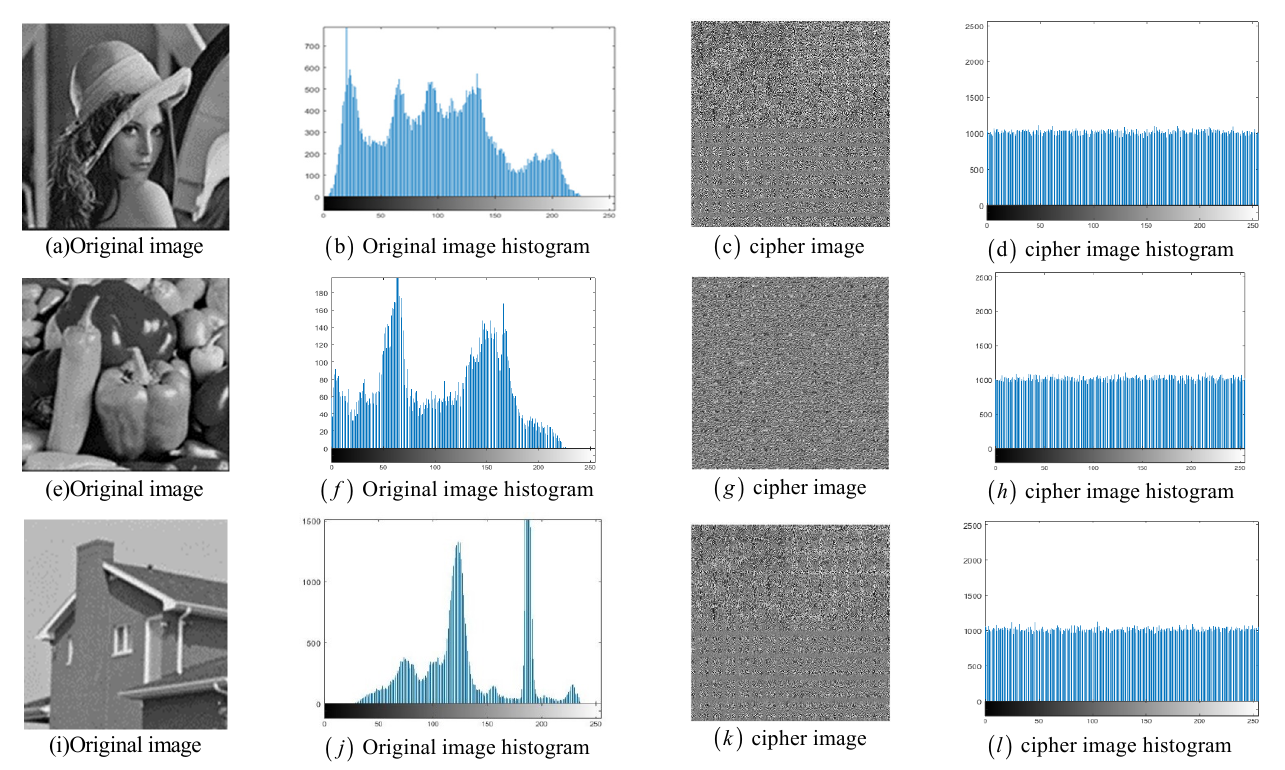
Figure 11. Histogram of 128 × 128 plaintext in